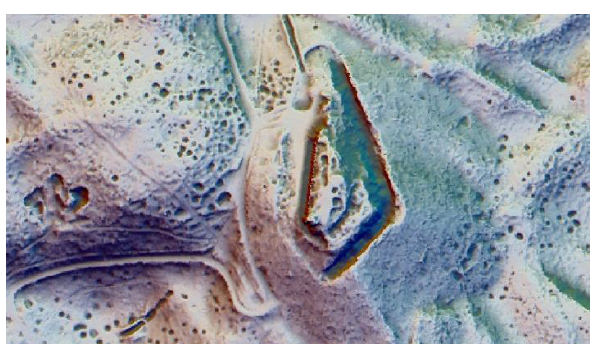
Figure 18 . Sky-View Factor and Multi-hillshading visualization Lidar Data, Busa Verle